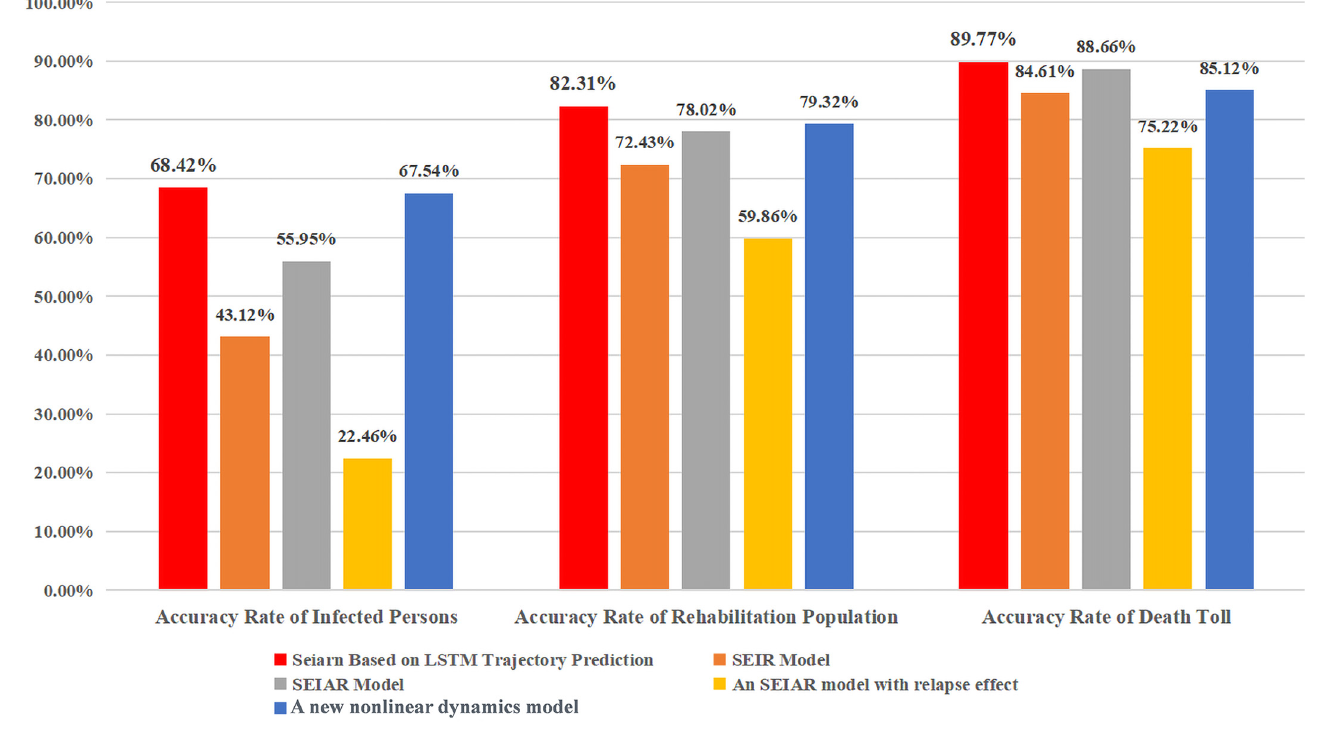
Figure 18. Schematic diagram of model comparison results.